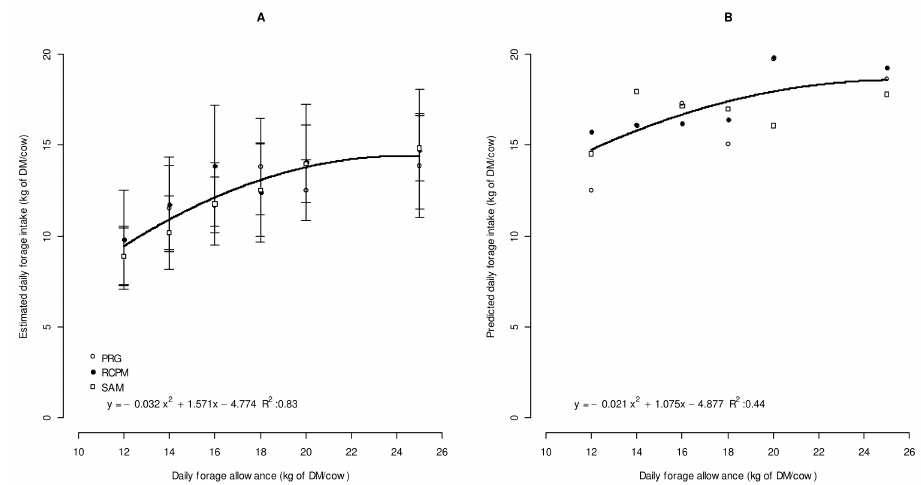
Figure 4. ( A ) Impact of forage allowance on estimated forage intake (estimated from pre- and post-grazing forage biomass) and ( B ) predicted forage intake (predictions based on the equations in CSIRO [53]) of three forage types, including PRG, perennial ryegrass; RCPM, perennial ryegrass, white clover and plantain mixture; and SAM, spatially adjacent monocultures of perennial ryegrass, white clover and plantain. Symbols are means ± SEM ( n = 4) for estimated forage intake, while symbols for predicted forage intake represent overall values for the experimental period. Solid lines show the overall regression models developed between explanatory and outcome variables. Table 5. Selection differentials for perennial ryegrass, white clover and plantain by early lactation dairy cows grazing three forage types at six forage allowances. Forage types included PRG, perennial ryegrass monoculture; RCPM, perennial ryegrass, white clover and plantain mixture; and SAM, spatially adjacent monocultures of perennial ryegrass, white clover and plantain. Values with different scripts are significantly different ( p < 0.05). At the interaction level, values with different upper-case scripts differ within a forage allowance, while values with different lower-case scripts differ within a forage